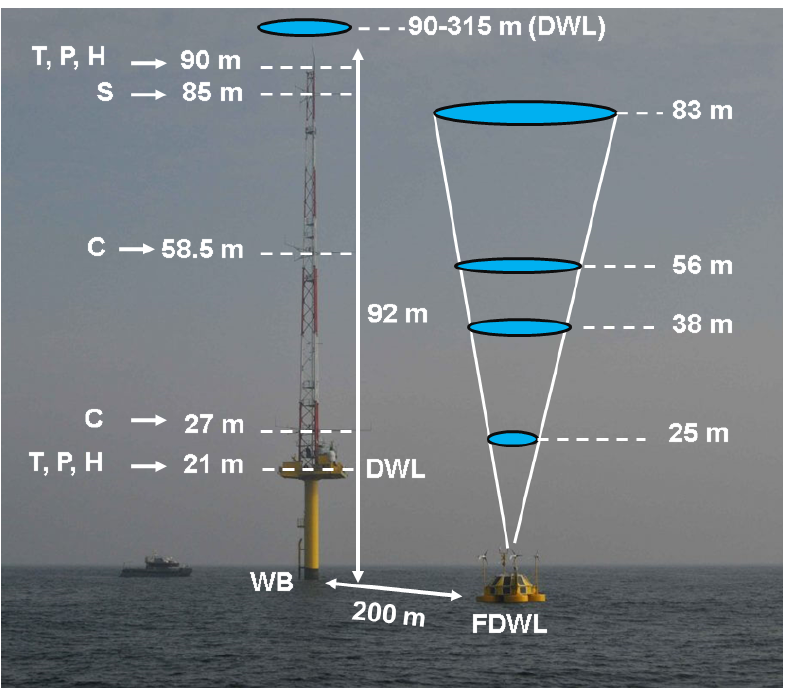
Figure 1. Instrument set-up at the IJmuiden test site. The FDWL is in the foreground and the metmast is in the background. Labels: S, Metek TM sonic anemometer; C, Thies TM cup anemometer; DWL, fixed-to-mast DWL; T, temperature sensor; P, pressure sensor; H, humidity sensor; WB, TRIAXYS TM wave